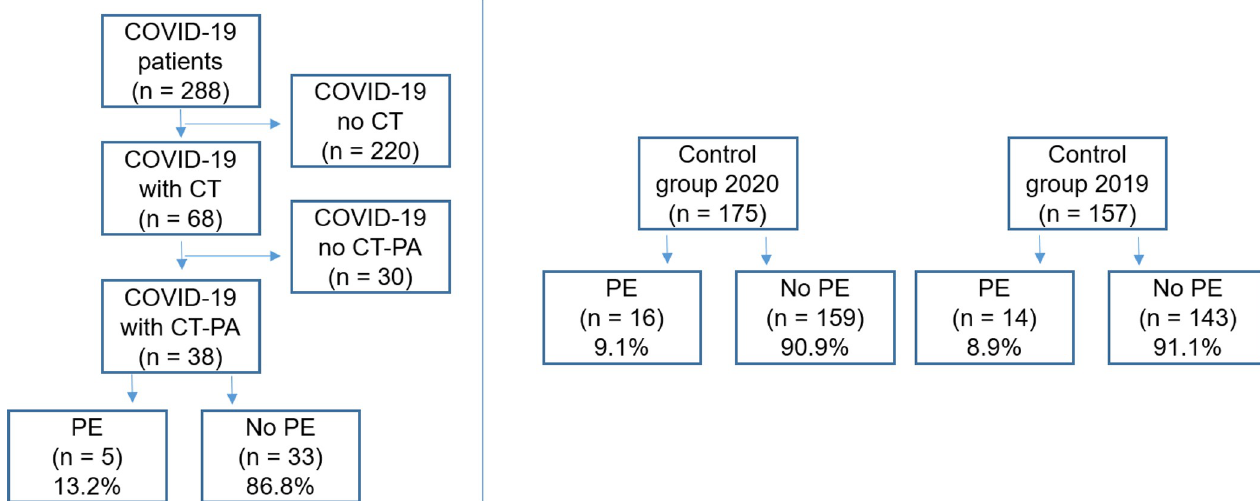
Fig 2. Patient inclusion and prevalence of pulmonary embolism. Pulmonary embolism (PE), number of patients (n), CT pulmonary angiography (CT-PA).